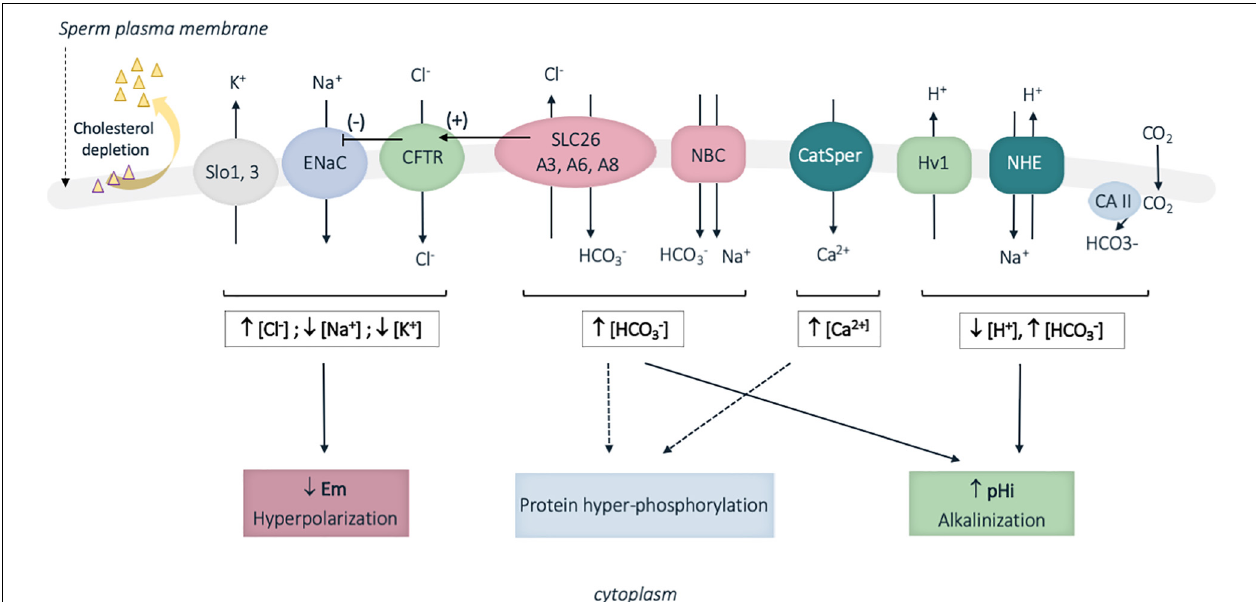
FIGURE 4 | Schematic representation of some of the identified sperm membrane transporters involved in ion fluxes during human sperm capacitation. Cholesterol depletion occurring during capacitation also increases membrane fluidity. A panoply of ion transporters is involved in the complex ion fluxes, which induce membrane hyperpolarization, cytoplasm alkalinization and protein hyperphosphorylation. Slo13, sperm-specific K + channel; ENaC, epithelial Na + channel; CFTR, cystic fibrosis transmembrane conductance channel; SLC26, solute carrier 26; NBC, sodium HCO 3 − transporter; CatSPER, sperm specific Ca 2 + channel; Hv1, proton channel; NHE, Na + /H + exchanger; CA, carbonic anhydrases; pH i , intracellular pH; Em, membrane potential; [ ... ], cytoplasmic ion concentrations; ↑ , increase; ↓ , decrease. Plain and broken arrows indicate a direct and indirect effect, respectively. CFTR stimulation by SLC26 proteins is represented by an arrow with (+) and ENaC inhibition by CFTR is represented by an arrow with